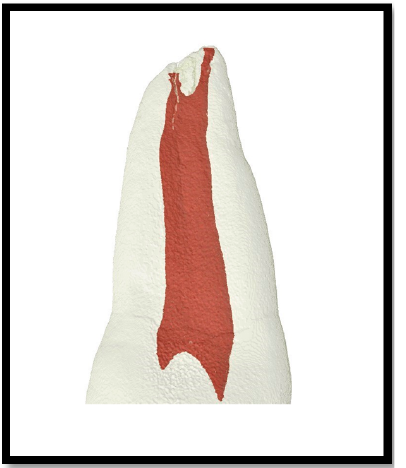
Figure 5. Micro-CT image showing Vertucci’s type V (1-2) canal configuration.